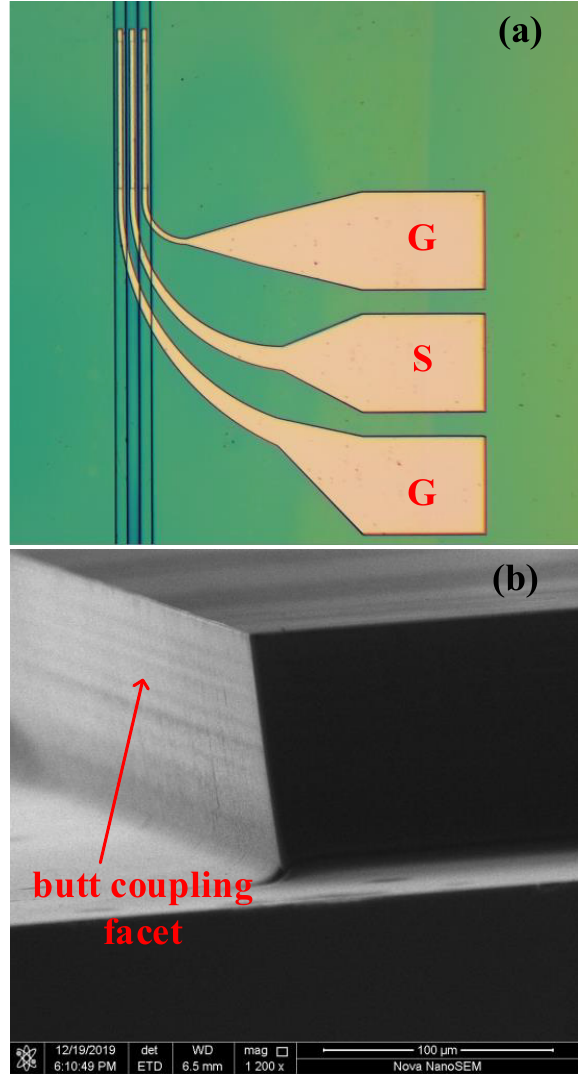
Figure 5: (a) Metalloscope image of the fabricated device. (b) SEM image of the butt coupling facet.